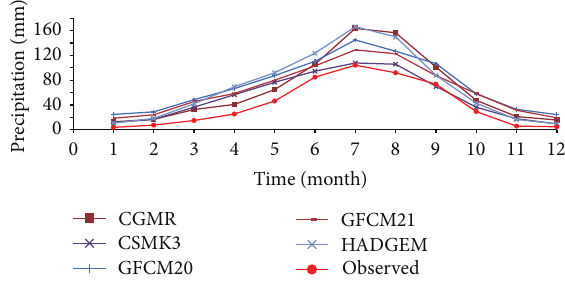
Figure 3: Comparison of five best-performance climate models for